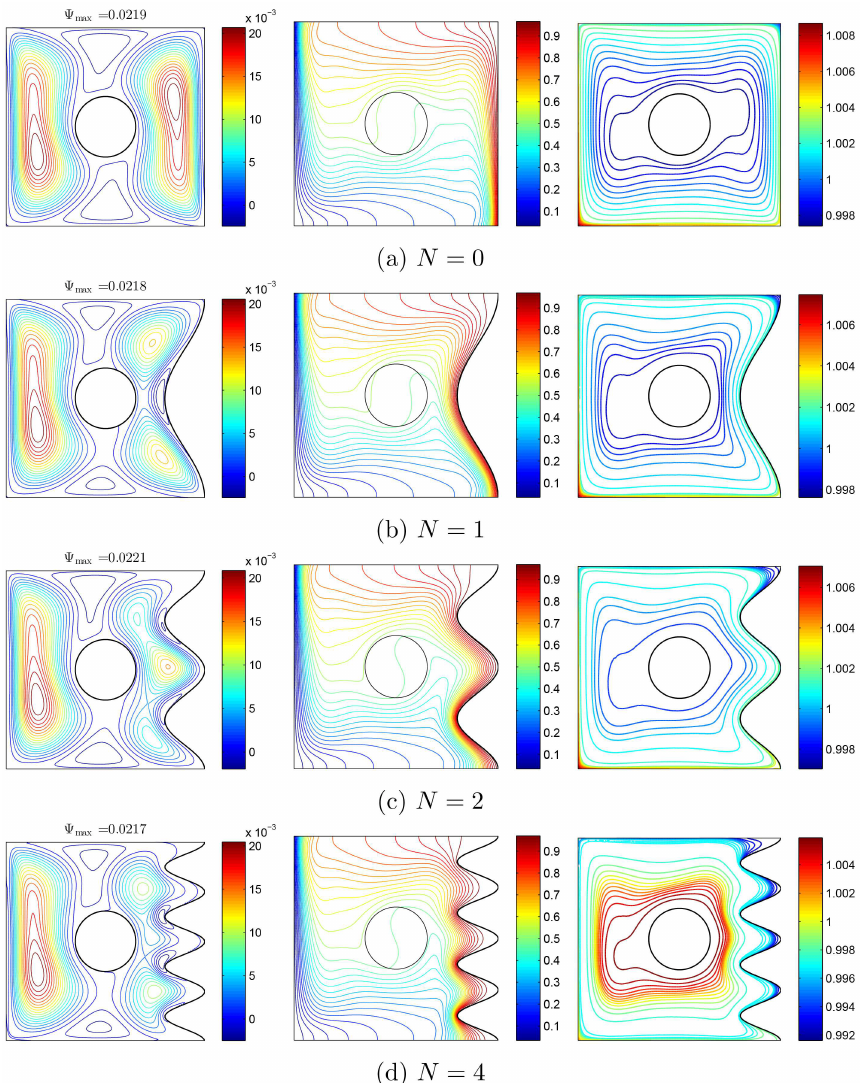
Figure 13. Variations of the ( left ) streamlines, ( middle ) isotherms, and ( right ) nanoparticle distribution evolution by number of undulations ( N ) for Case 1 ( Ω ), Ri = 10, φ = 0.02, and R =